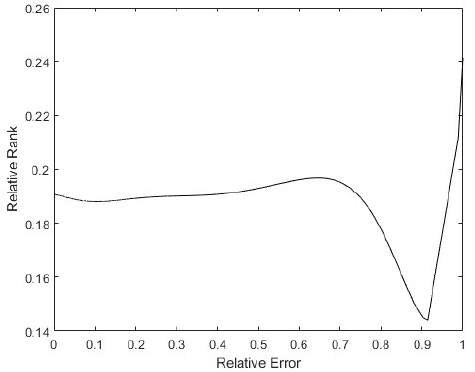
Figure 33. Polynomial regression of relative rank to relative error on X 2 .